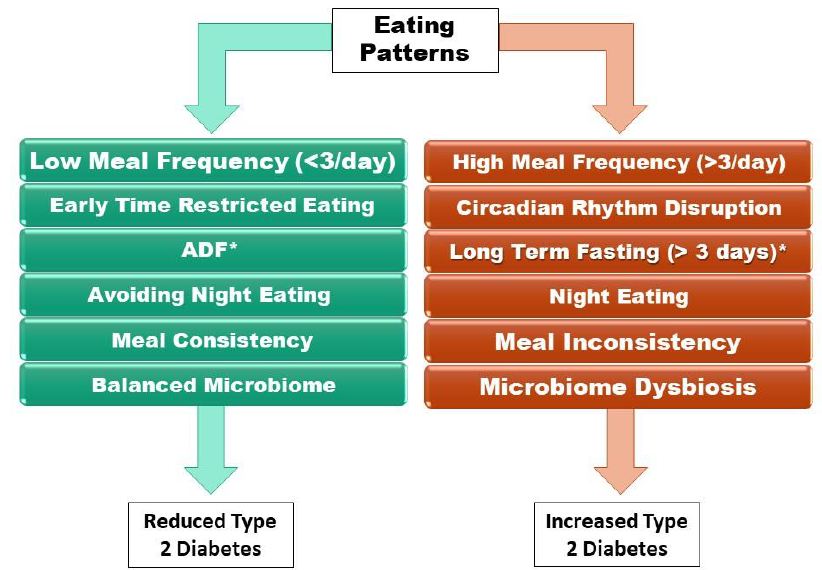
Figure 1. The effects of circadian eating pattern adjustments on T2D. Eating patterns that reduce T2D include lowering the meal frequency to below 3 meals a day and early time-restricted eating. Alternate-day fasting (ADF*) reduces T2D with a risk of eating disorders (bulimia and binge eating). Avoiding night eating, maintaining meal consistency and a balanced microbiome have been shown to reduce T2D. High meal frequency and disruption of the circadian rhythm increase T2D. Long-term fasting without a doctor’s supervision (*), eating at night, meal inconsistency or consuming food that induces gut dysbiosis all increase T2D.